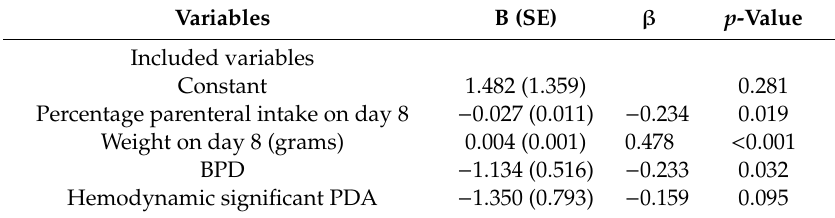
Table4. RegressionanalysesofparenteralnutritionasapredictorofIGF-1levelsat2weekspostnatalage.